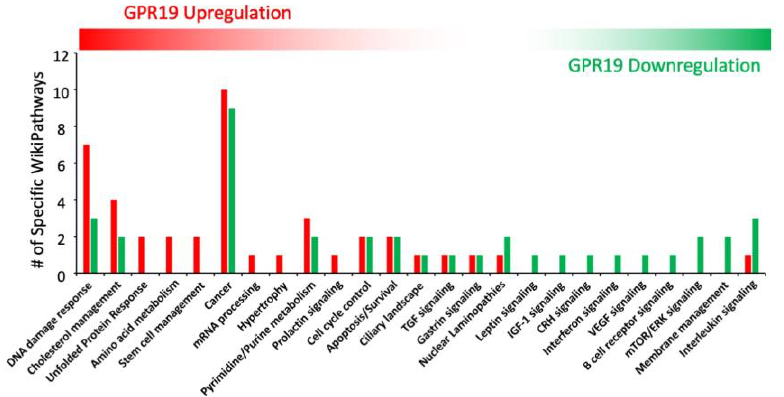
Figure 3. Distribution of WikiPathway significant population profile between either GPR19 upregu- lated or GPR19 downregulated profiles. The WikiPathways significantly enriched by at least three out of the four initial data inputs (Figure 2) were then clustered according to their divergent number of functionally similar pathways. WikiPathway groups more populated by the GPR19 upregulated datasets are left-most in the histogram, and the WikiPathway groups more populated by the GPR19 downregulated datasets are right-most in the histogram. Thus, GPR19 upregulation profiles are most strongly associated with DNA damage response, cholesterol metabolism, and the unfolded protein response, while GPR19 downregulation profiles are more strongly linked to interleukin signaling, plasma membrane regulation and mTOR signaling.